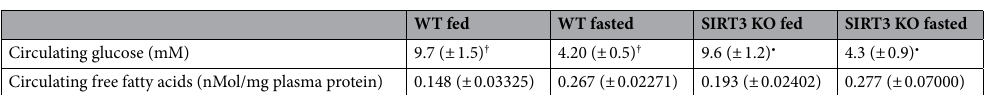
Table 1. Fasting significantly reduces circulating glucose in starved WT and SIRT3 KO mice. (Data are mean ± SEM). †,• p < 0.05 One-Way ANOVA with a Tukey post-test comparing within genotype. N =